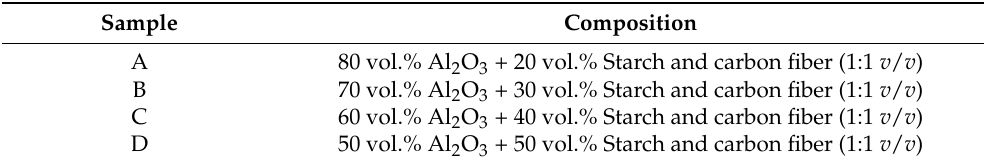
Table 1. Ratios of the raw materials in the samples.